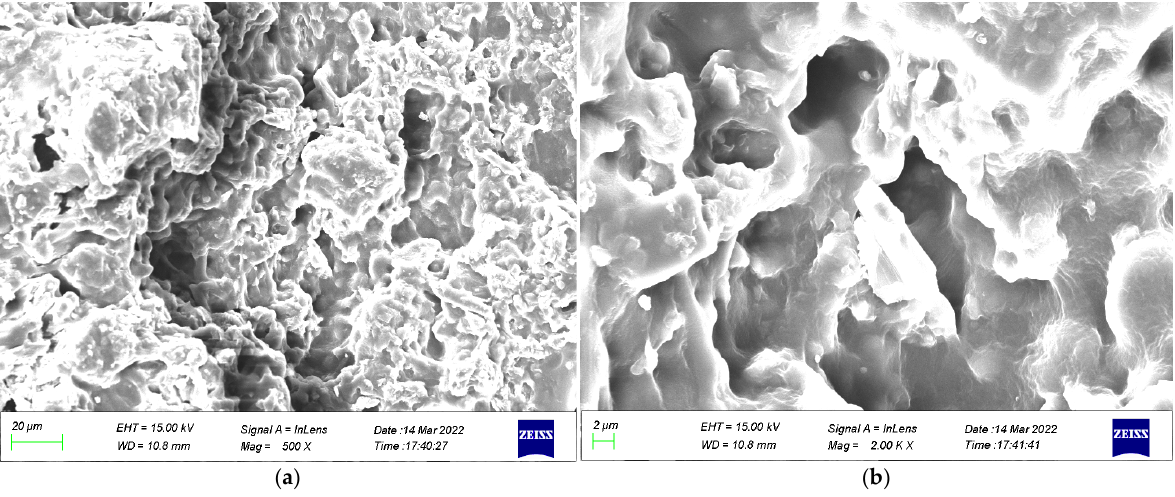
Figure 20. Micro-structure of aggregate, WER content 20%: ( a ) 500×; ( b ) 2000×.